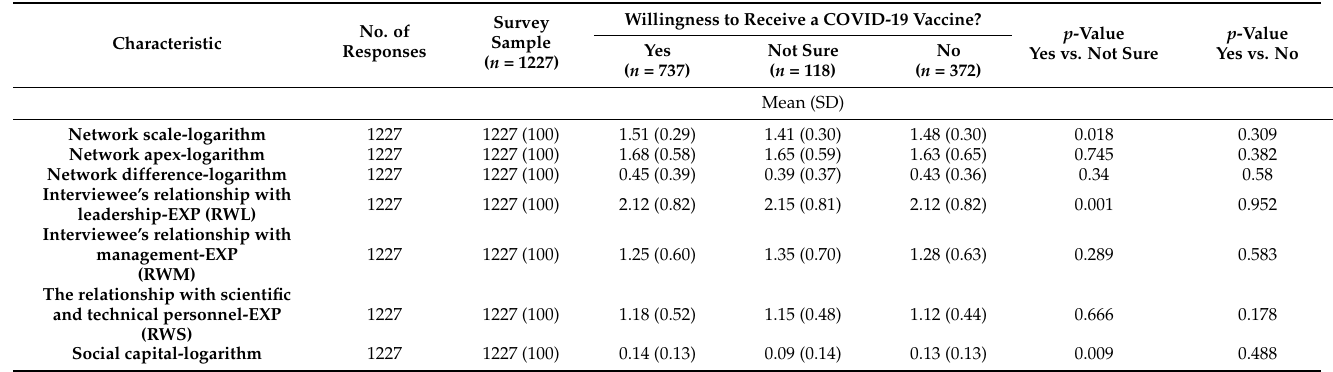
Table 6. t -test on social capital and willingness to the vaccine booster